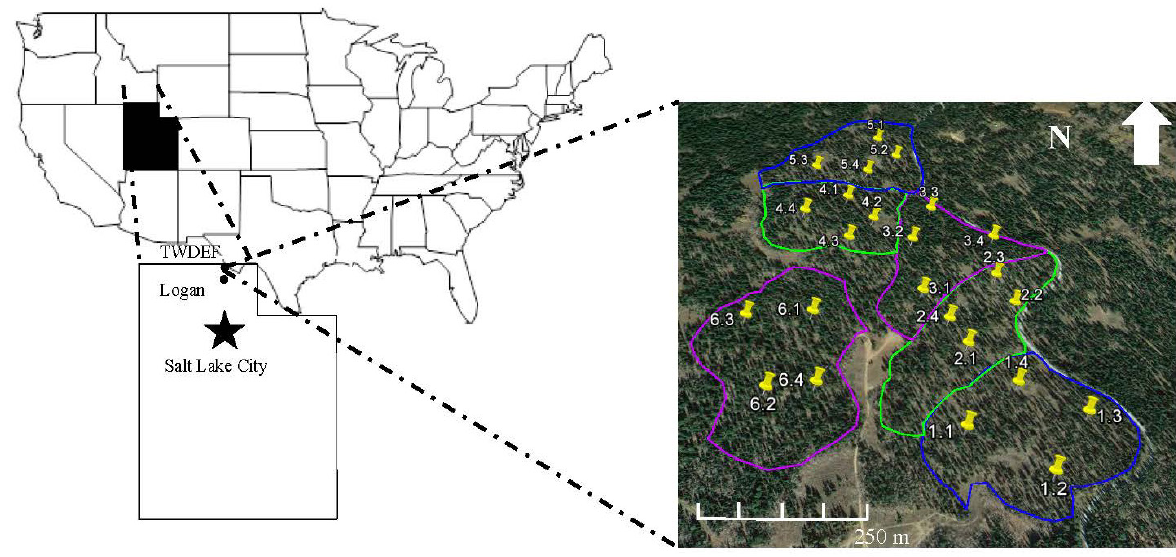
Figure 1. Location and study design layout for the spruce-fir silvicultural treatments at the Utah State University’s T.W. Daniel Experimental Forest (TWDEF). Each treatment is outlined in a different color: shelterwood with reserves (blue); group selection (green); single tree selection (purple). Plot locations are highlighted in yellow. A stratified random sampling design was used within each treatment. Additional information on data collected at each sampling point can be found in following paragraphs and Figure 2. The map with the plot locations was made in Google